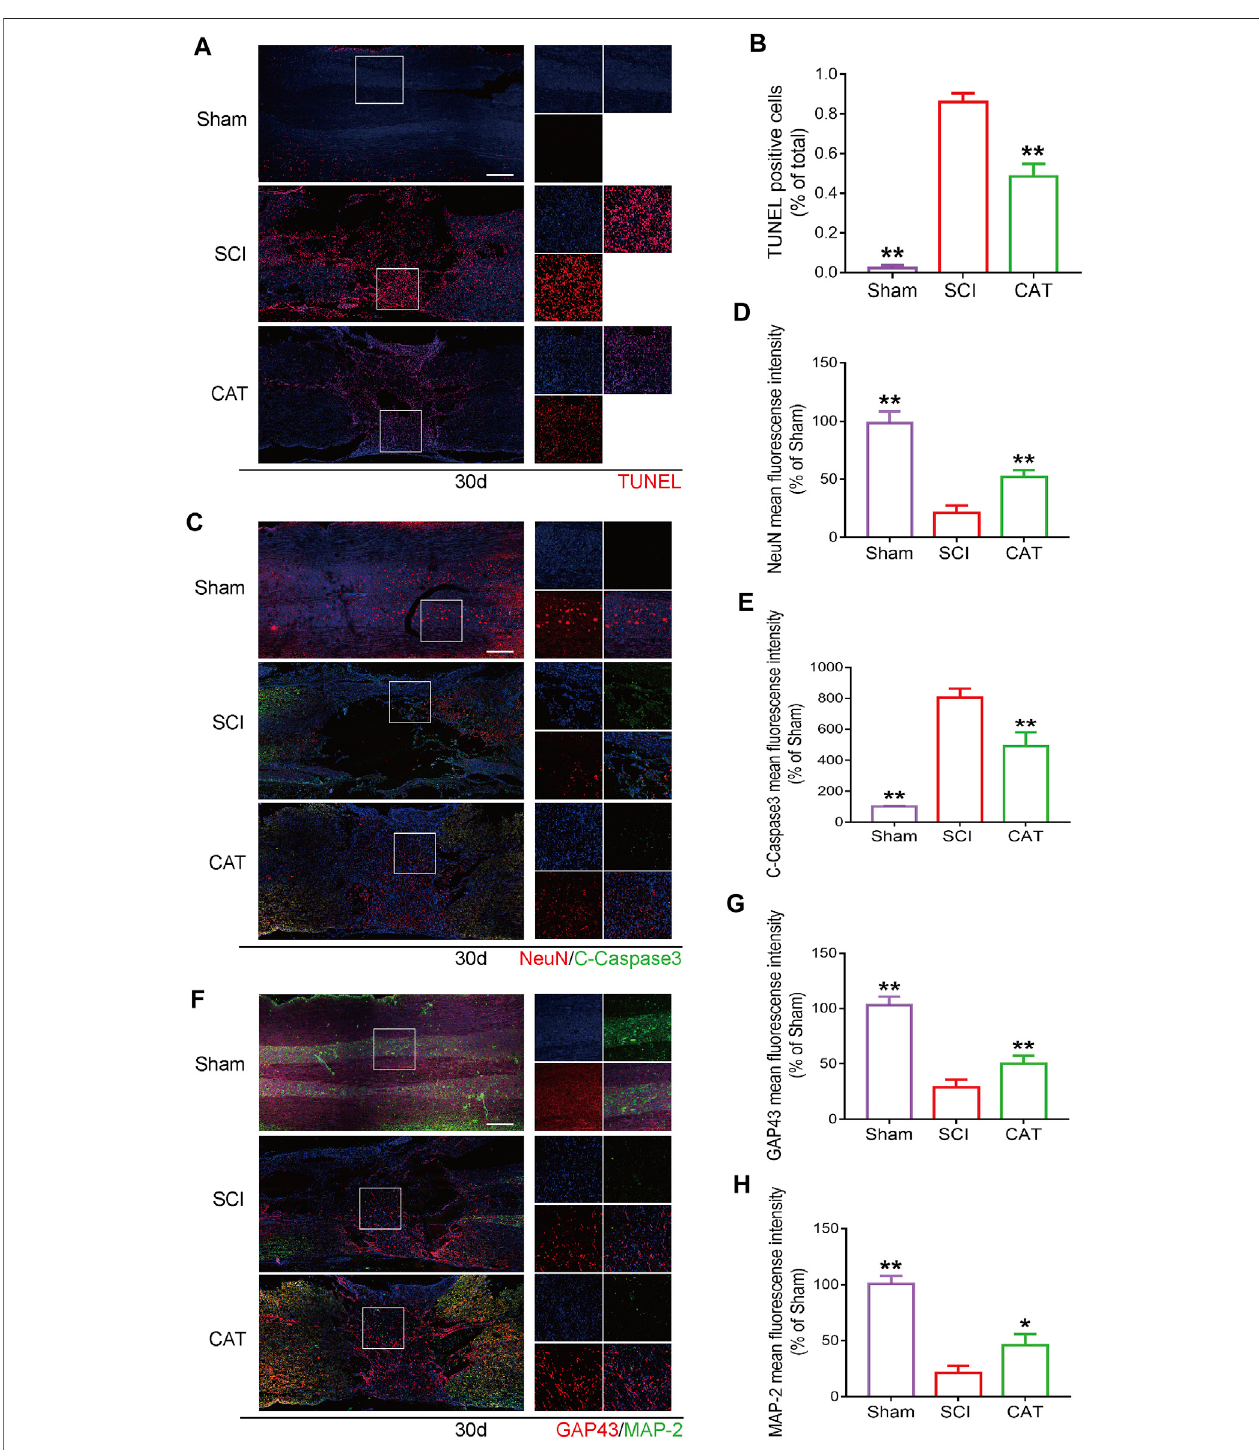
FIGURE5| CATinhibitsneuronapoptosisandupregulatesneuroprotectivefactorsinSCIrats. (A) TUNELstainingofSCIareaandmagni fi cationis×4. (B) Analysis of the TUNEL staining results. (C) Immuno fl uorescence staining of NeuN (bright red) and C-Caspase-3 (bright green), which represents neurons in the Sham group, the SCI group, and the CAT group. (F) Immuno fl uorescence staining of GAP43 (bright red) and MAP-2 (bright green). The nuclei are labeled by DAPI (blue), and the magni fi cation is ×4. (D,E,G,H) Quantitative analysis of immuno fl uorescence staining signals. Student ’ s t test was used to analyze immuno fl uorescence results. “ * ” represents p < 0.05, “ ** ” represents p < 0.01 versus the SCI group with statistical signi fi cance. Data are represented as mean ± SD ( n = 3).